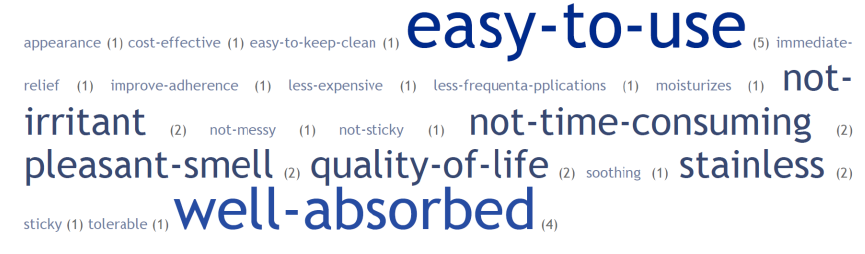
Figure 2. Word cloud representing keywords linked to the patient preference to topical formulations. The difference in character dimension is related to the frequency in Ref. [54].